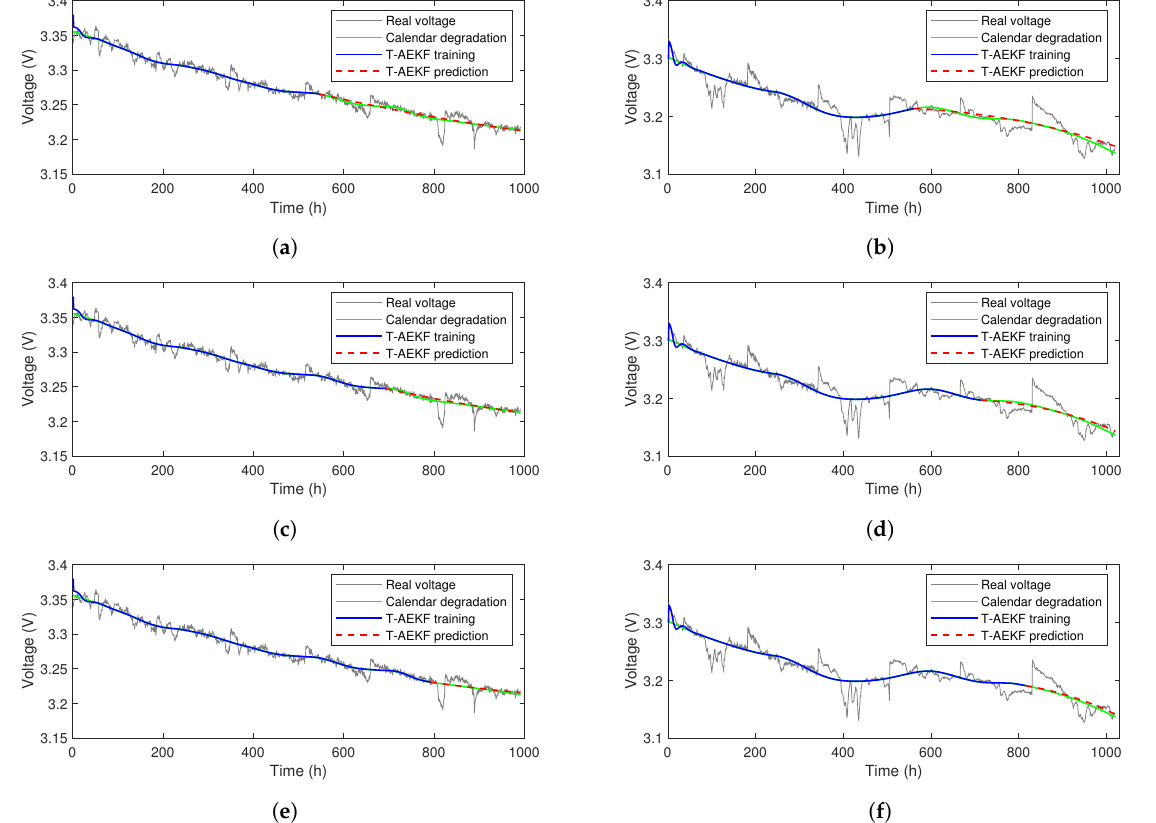
Figure 7. The prediction results based on T-AEKF. ( a ) FC1 with 55% training data; ( b ) FC2 with 55% training data; ( c ) FC1 with 70% training data; ( d ) FC2 with 70% training data; ( e ) FC1 with 80% training data; ( f ) FC2 with 80% training